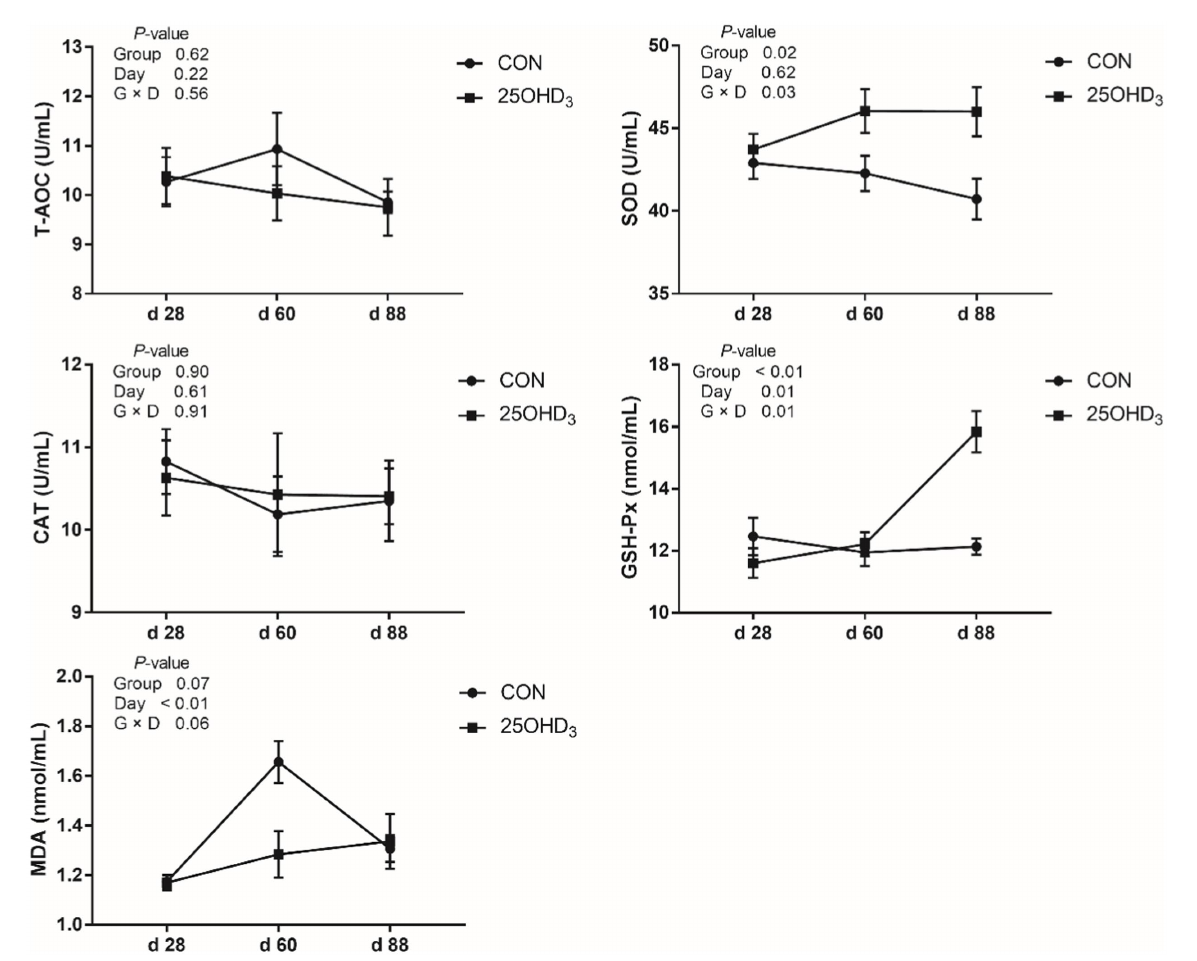
FIGURE 1 The serum antioxidant parameters between the two treatments. Values are shown as the means ± SEM, n = 5. T-AOC, total antioxidant capacity; SOD, superoxide dismutase; CAT, catalase; GSH-Px, glutathione peroxidase; MDA,